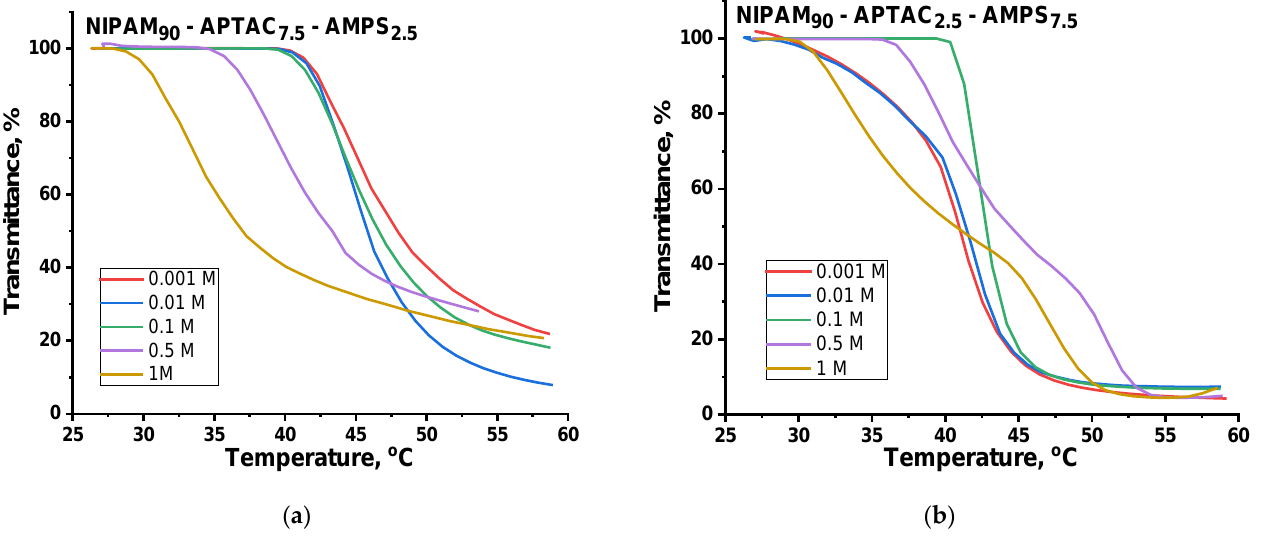
Figure 9. Effect of temperature and ionic strength (μ) on transmittance of ( a ) NIPAM 90 -APTAC 7.5 - AMPS 2.5 and ( b ) NIPAM 90 -APTAC 2.5 -AMPS 7.5 solutions. AMPS 2.5 and ( b ) NIPAM 90 -APTAC 2.5 -AMPS 7.5